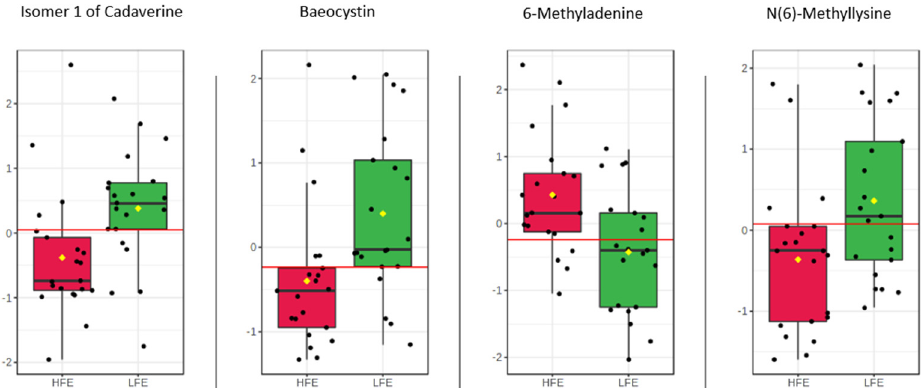
Figure 4 . Relative distributions of the metabolites associated with divergent RFI phenotype in beef steers (isomer 1 of cadaverine, baeocystin, 6-methyladenine, N(6)-methyllysine). HFE (red) = beef steers with negative residual feed intake; LFE (green) = beef steers with positive residual feed intake .